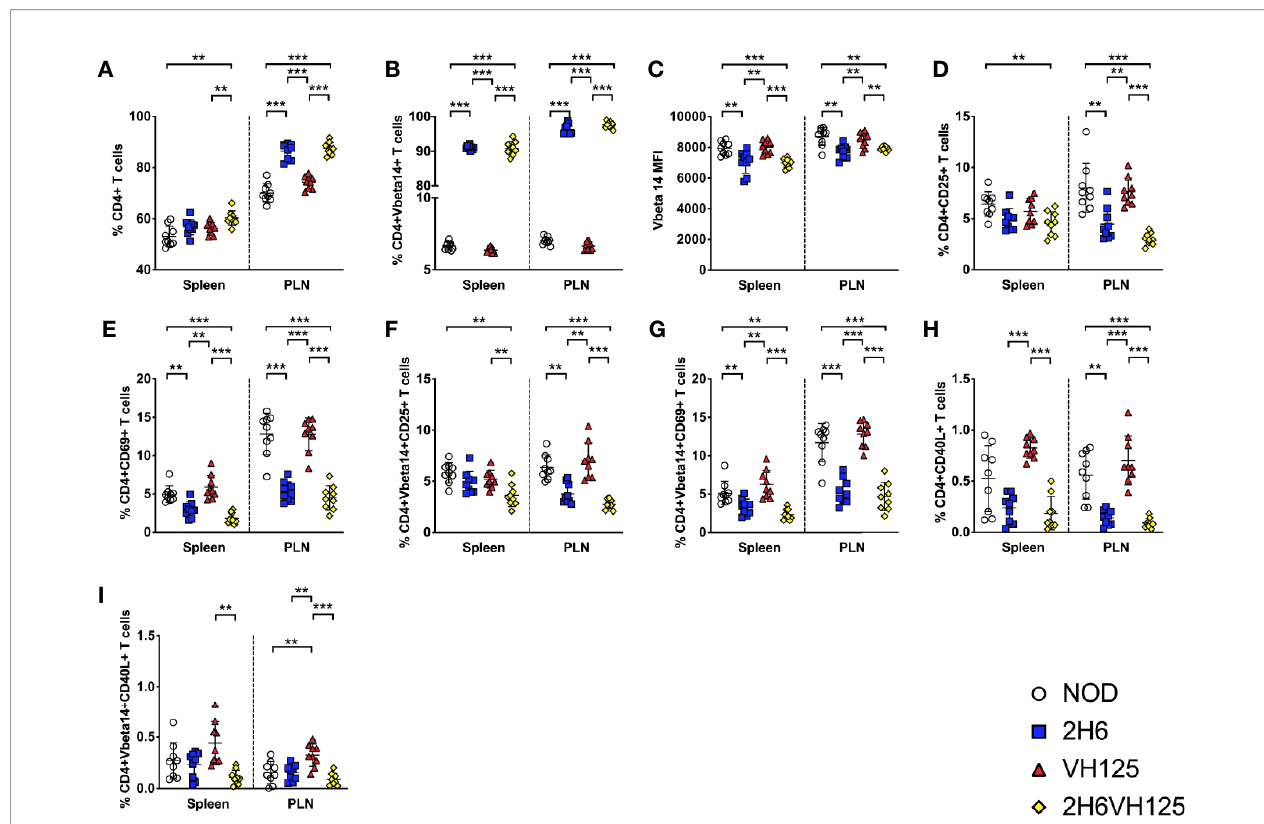
FIGURE 1 | VH125 BCR transgene does not in fl uence 2H6 T cell phenotype. Splenocytes and cells from the pancreas draining lymph nodes (PLN) were harvested from 8-week-old mice and stained using antibodies for fl ow cytometry. (A) % of live single CD4+CD8-CD19- T cells. (B, C) % and mean fl uorescent intensity (MFI) of TCRV b 14+ (the TCRV b chain used in the 2H6 TCR transgene) in CD4+ T cells gated from (A) . (D – G) % of CD4+CD25+ T cells and CD4+CD69+ T cells gated on total CD4+ T cells and CD4+ TCRV b 14+. ( H – I ; % of CD4+CD40L+ T cells gated on total CD4+ T cells and CD4+ TCRV b 14+. Data were generated from 9 to 10 individual mice pooled from 4 to 5 independent experiments. Data from left to right: NOD, 2H6, VH125, and 2H6VH125 are shown in this order in each plot. Data from NOD mice are shown as a non-transgenic mouse comparison. Data were assessed for signi fi cance using multiple T tests and FDR correction. **P < 0.001, ***P <